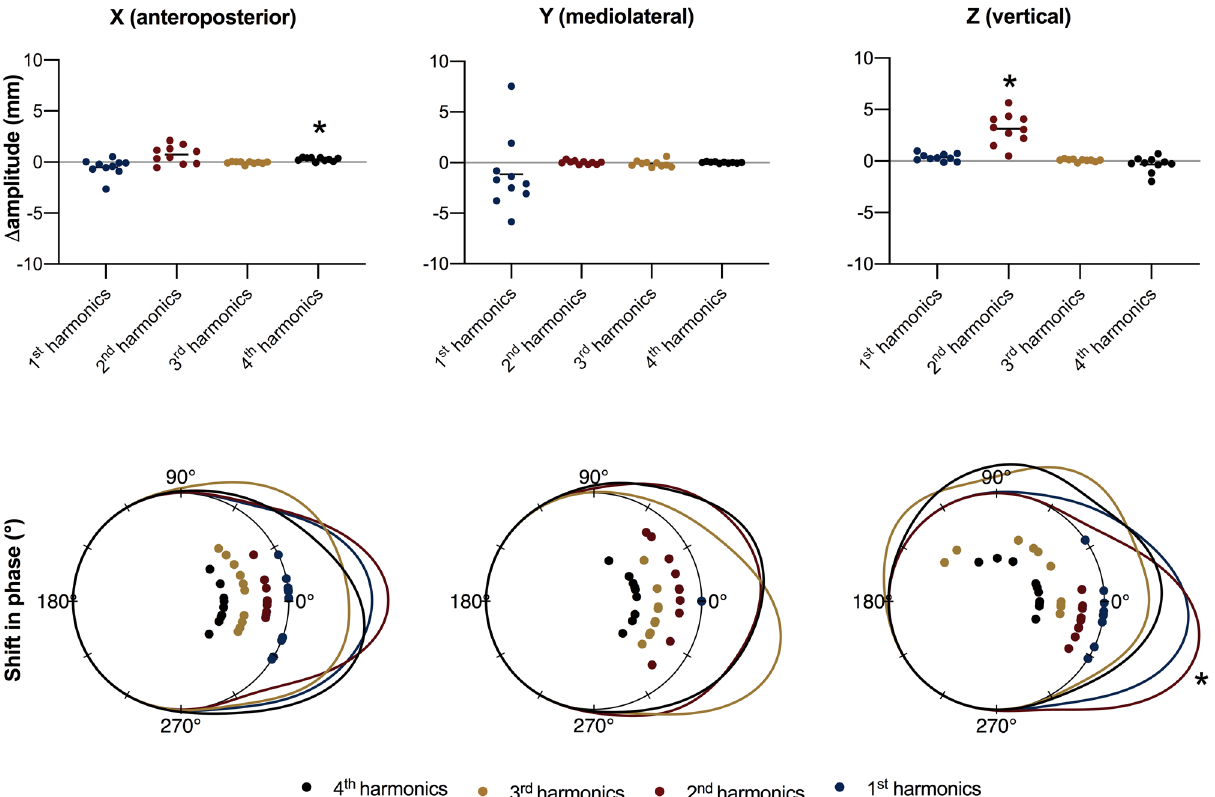
Figure 3. Variations in amplitudes and phases of the first four Fourier harmonics for each axis, while walking at 1.4 m/s as compared with 1.1 m/s. Top panel: Individual speed-dependent variations in harmonics amplitudes. Bottom panel: Individual speed-dependent variations in harmonic phases. Probability density functions for circular variables are shown as continuous curves. In Fourier analysis, the phase of the first mediolateral (y) harmonic was conventionally set to zero for all trajectories in order to align them. *p < 0.05; paired linear or circular test for differences with Benjamini–Hochberg correction for multiple